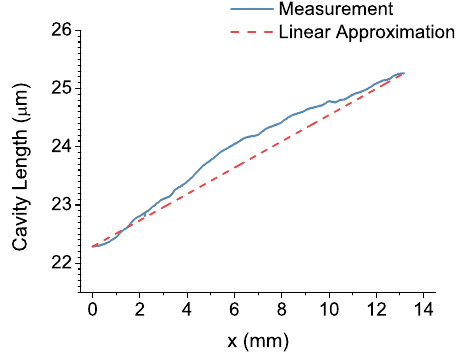
Figure 10. Cavity length calculated using the profile measurements of the flat and the tapered mirrors with the related linear approximation of the slope.